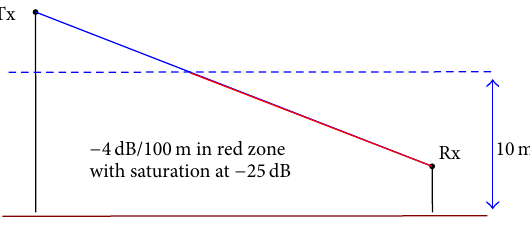
Figure 6: Correction factor adopted for